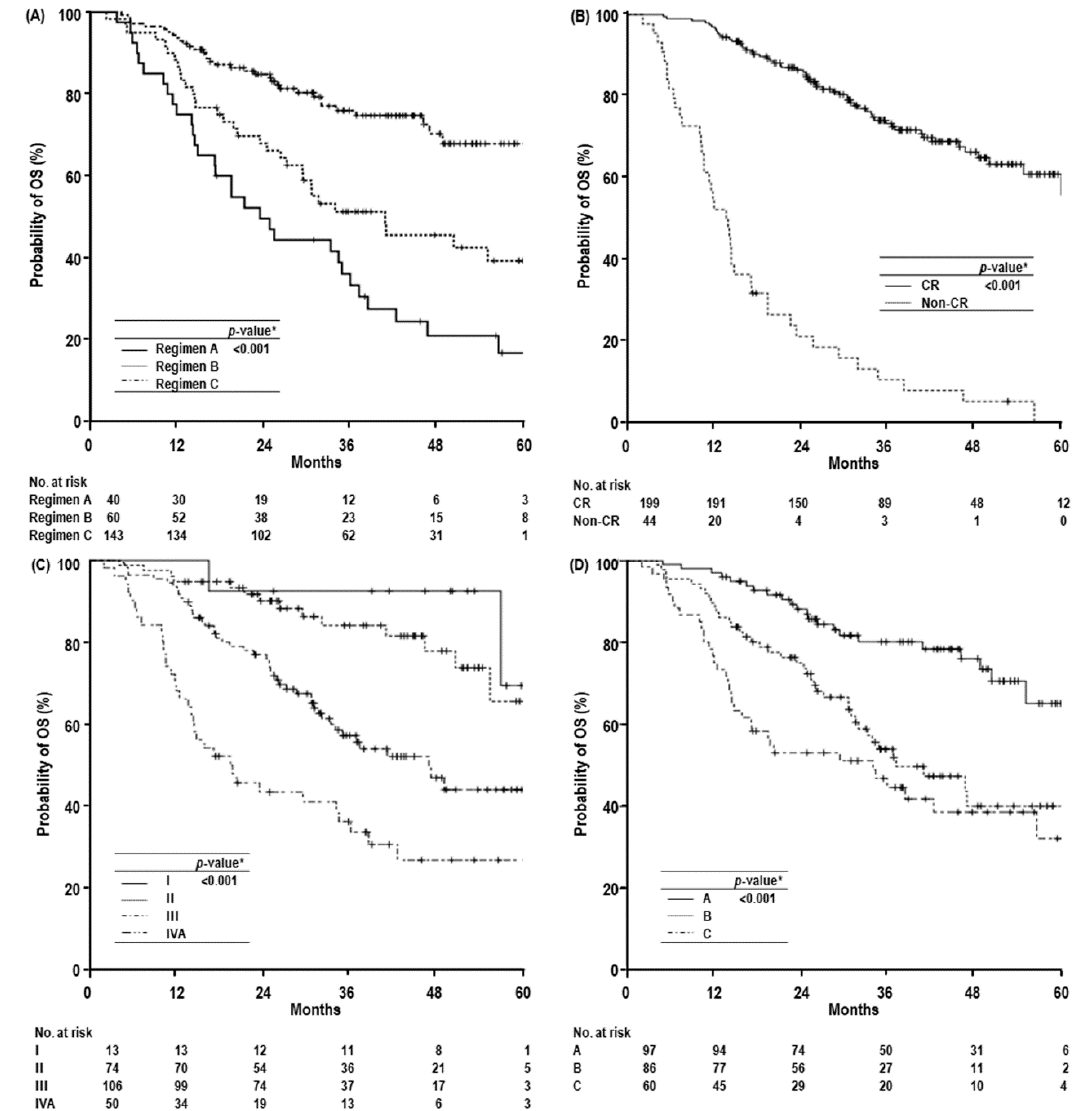
Figure 3. Overall survival (OS) curves according to dose-fractionation regimens ( A ), primary tumor response ( B ), mUICC stage ( C ), and BCLC stage ( D ). Abbreviations: mUICC stage, modified International Union against Cancer stage; BCLC stage, Barcelona Clinic Liver Cancer stage; yr, year; CI, confidence interval; CR, complete response. * Log-rank test.